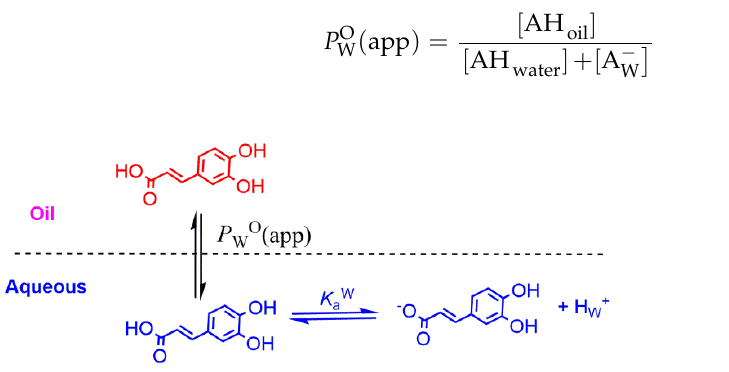
Figure 8. Partitioning of a model phenolic acid antioxidant (caffeic acid) between the oil (O) and water (W) phases of binary mixtures.